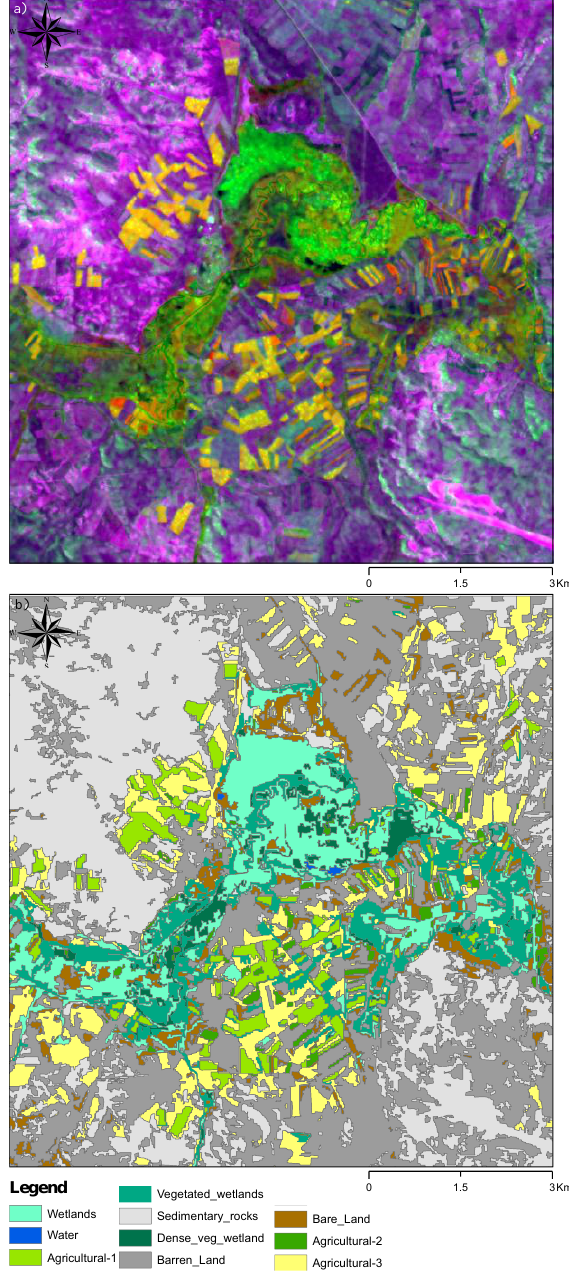
Figure 4. a) Data Set (RGB – NIR, VH, Red); b) Classification results of Balikdami